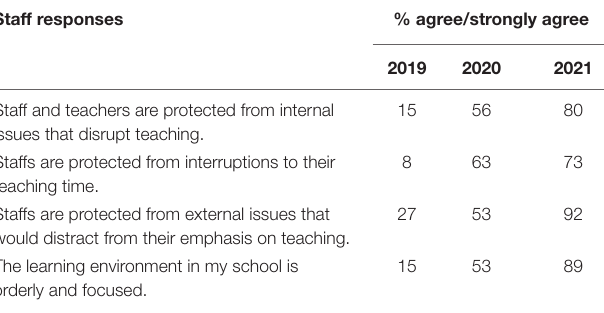
TABLE 4 | School staff surveys – the learning environment. Staff